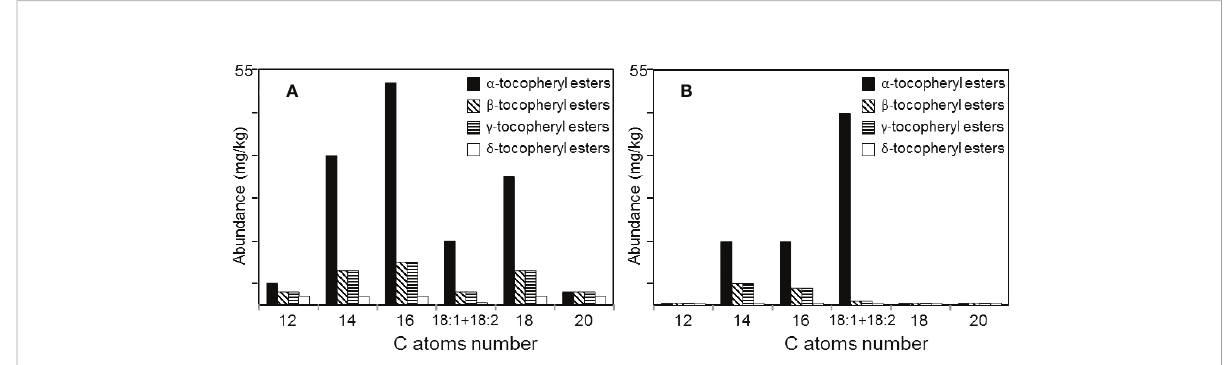
FIGURE 8 Distribution of the different series of tocopherol esters among the lipids of (A) the rind, and (B) the pith of papyrus